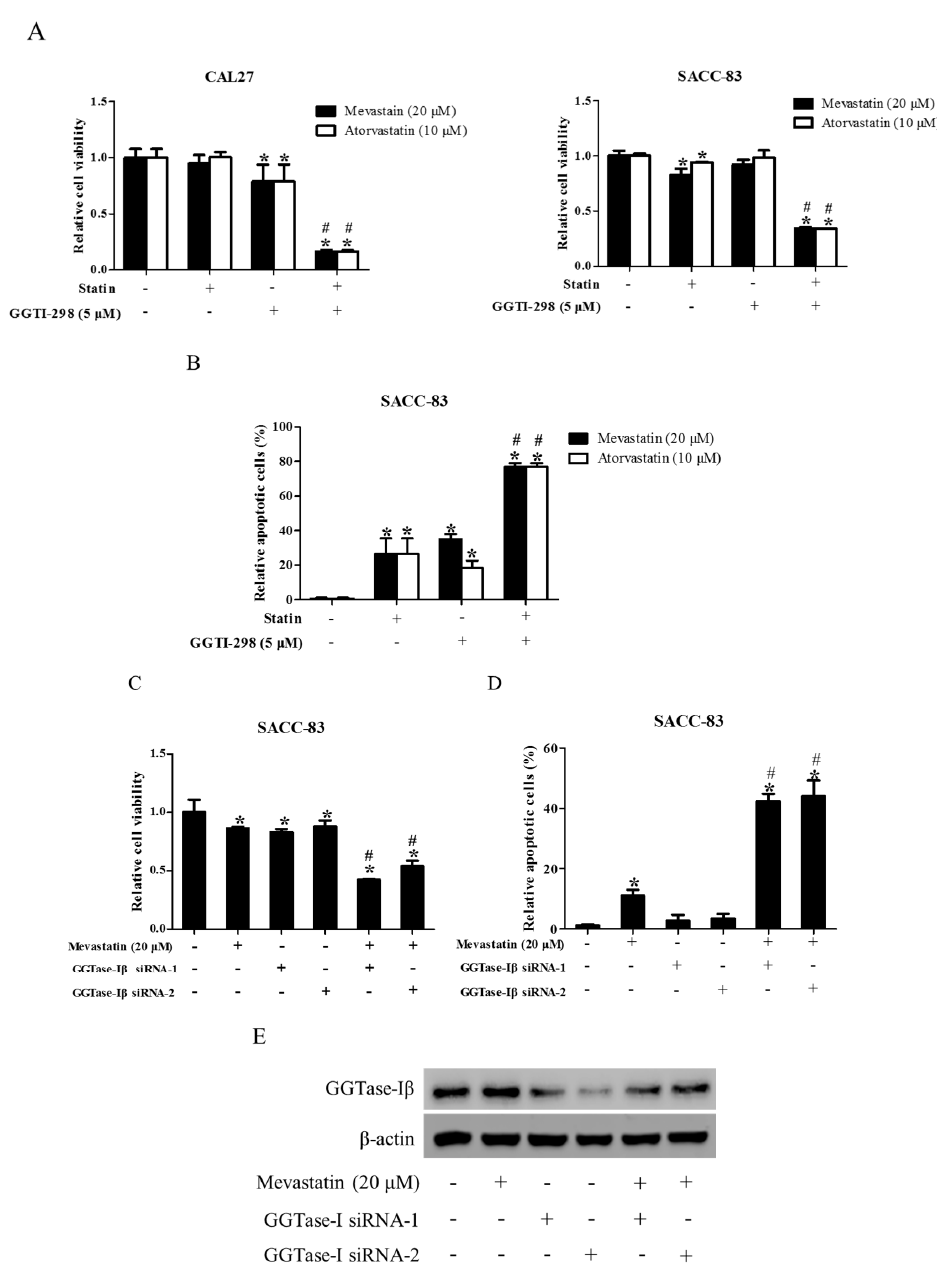
SACC-83 cells. Moreover, knockdown of GGTase-I β by siRNAs also enhanced the statin-induced inhibition of cell proliferation (Figure 4C) and apoptosis (Figure 4D).